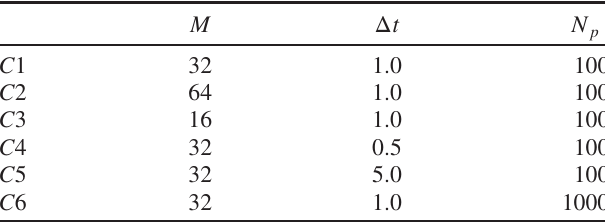
FIG. 6. The stress-optical relation ¯ σ xy = indicate the present results, and the symbols plus, times, and asterisk indicate the results obtained in Ref. [38] at uniform